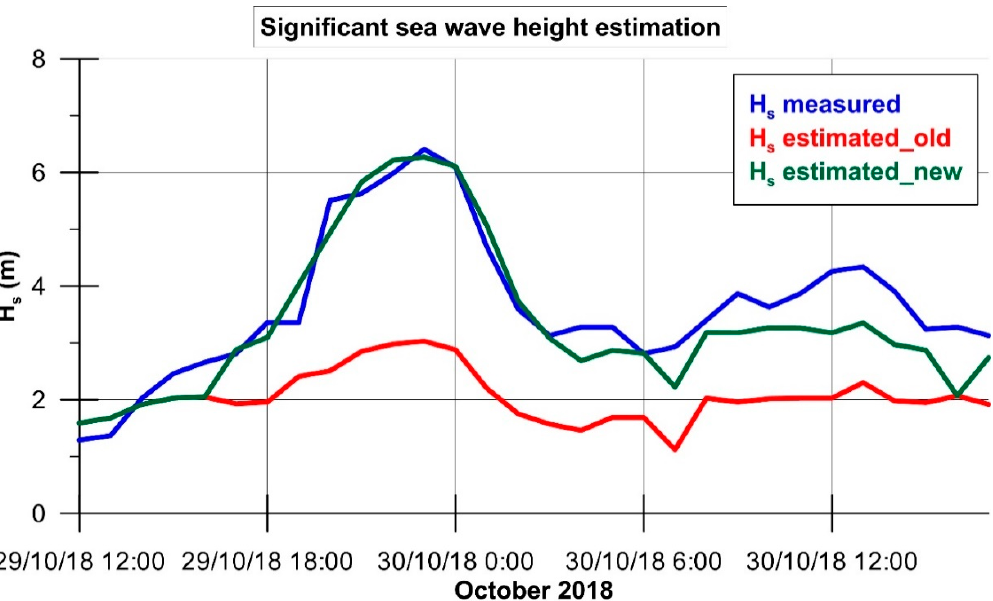
Figure 9. Comparison between H s measured by the buoy (blue line) and those provided by model of Ferretti et al. [15] before (red line) and after (green line) the application of the correction term.